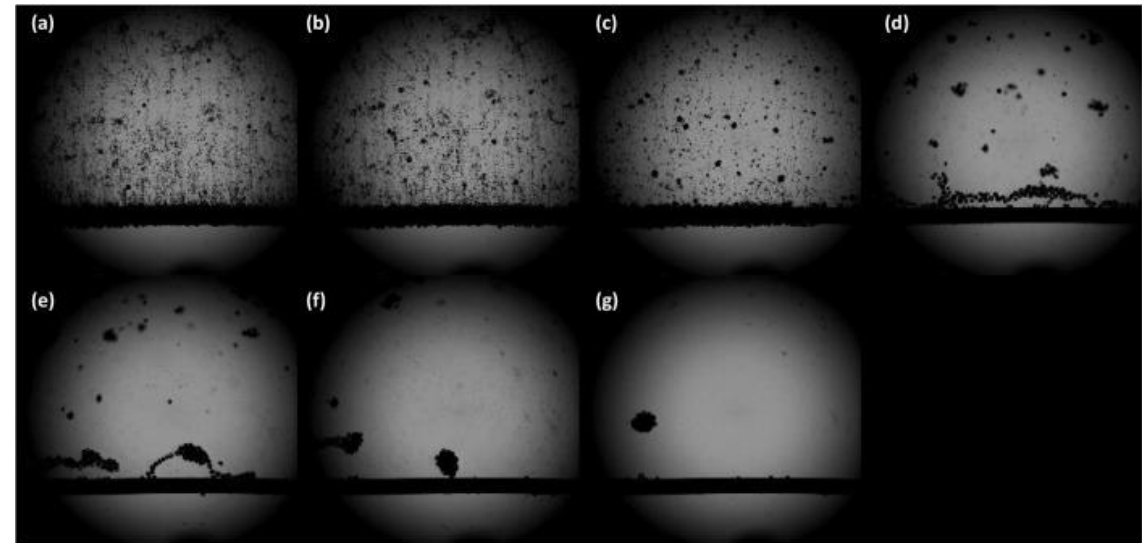
Figure 4. Hydrogen evolution on a Pt wire in the absence (top left corner) and presence of ultrasound (26 kHz, 100% ultrasonic amplitude). The applied potential was set at −1.30 V vs. RHE ( a ) 0 μs, ( b ) 100 μs, ( c ) 200 μs, ( d ) 300 μs, ( e ) 400 μs, ( f ) 500 μs, ( g ) 600 μs. The time between each image is 10 −4 s (100 μs) filmed at 10,000 frames per second [30].